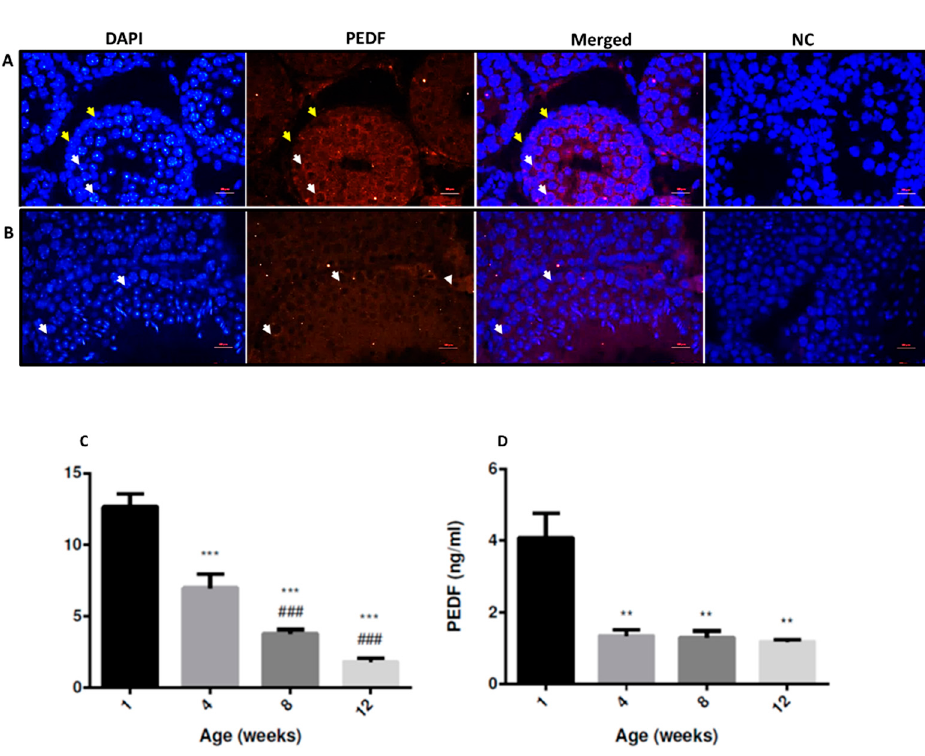
Figure 1. Immunostaining of pigment epithelium derived factor (PEDF) and its levels in testicular tissue and Sertoli cells. Paraffin embedded testicular tissue from 2-week-old (immature) mice ( A ) and from 8-week-old (mature) mice ( B ) were sliced, fixed on slides and immunofluorescence stained for PEDF (red) and DAPI (blue). Negative control (NC)—IF staining without the presence of primary antibody. PEDF levels were examined in testicular homogenates ( C ) and in Sertoli cells supernatants ( D ) by using specific ELISA. ( C ) N = 7–10. N—number of mice used for testis homogenates repeat. ( D ) N = 5–6. N—Number of experiments repeated for Sertoli cells supernatant. White arrows indicate stained cells, while yellow arrows indicate non-stained cells in the seminiferous tubule ( A ). ∗ —Statistical significance of mice in comparison to 1w, #—Statistical significance of mice in comparison to previous age. ∗∗ — p < 0.01, ∗∗∗ — p < 0.001. ###— p < 0.001. Scale bar: 100 µ